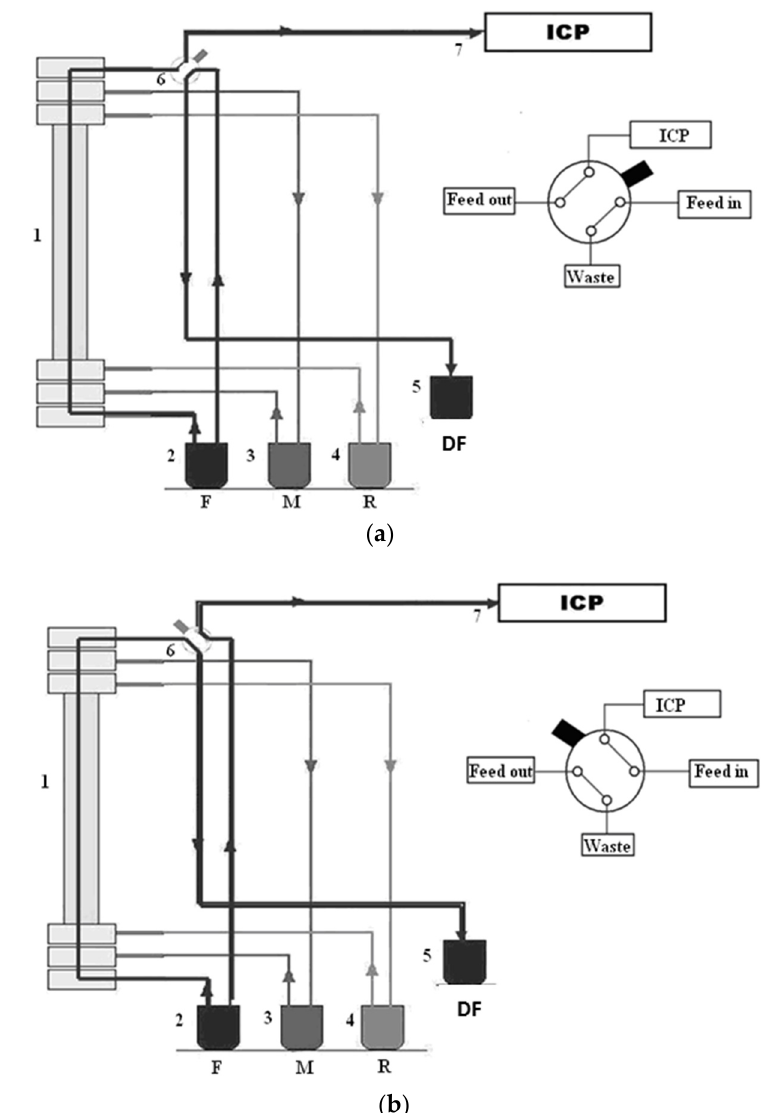
Figure 5. Scheme of the TMC/ICP-OES (tailor-made contactor/inductively coupled plasma optical emission spectrometry) instrumental equipment for Cr(III) and Cr(VI) on-line analysis. In panel ( a ), the solution at the output of the contactor (feed out) arrives at the ICP-OES; in panel ( b ), the solution at the input of the contactor (feed in) reaches the ICP-OES. (1) Contactor; (2) feed solution (F); (3) membrane solution (M); (4) receiving solution (R); (5) drain feed solution (DF); (6) valve; (7) ICP-OES.